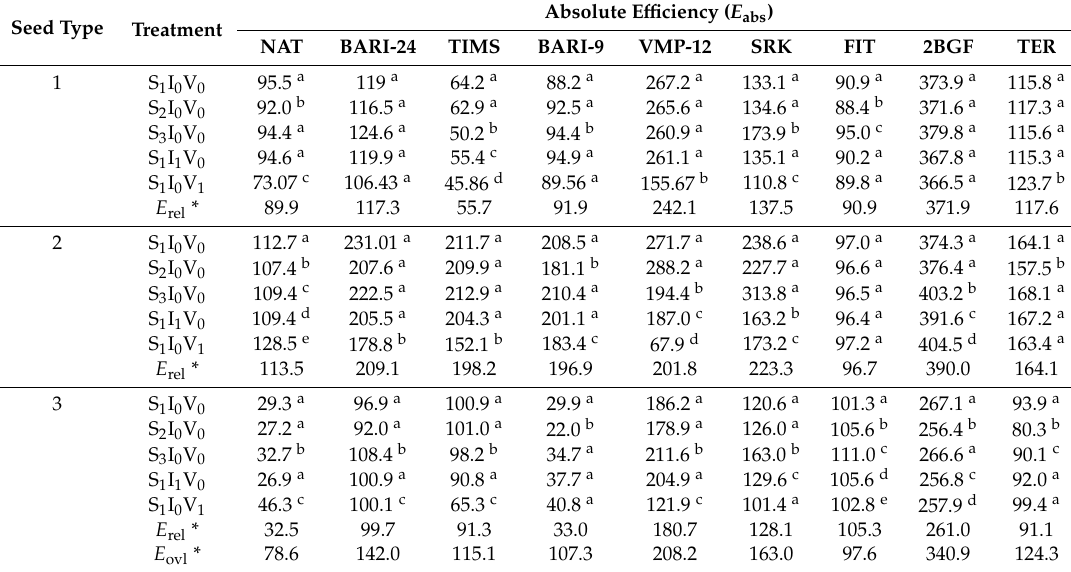
Table 4. Absolute, relative and overall e ffi ciencies per seed meter